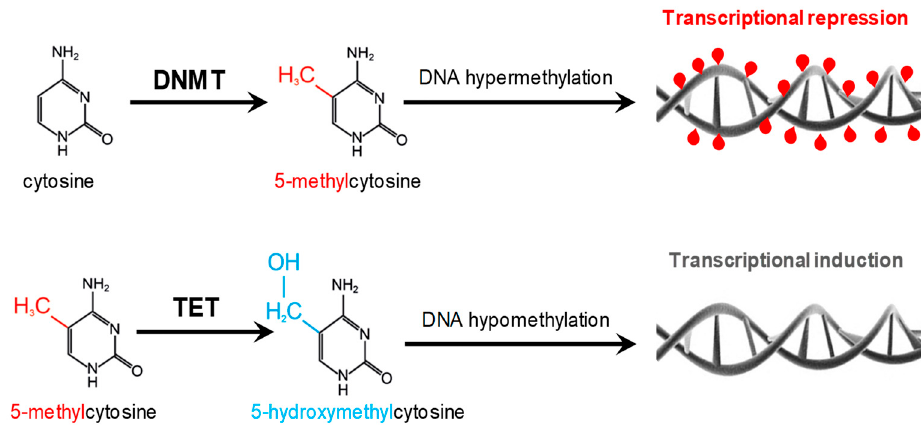
Figure 2. E ff ects of DNA hypermethylation ( upper ) and hypomethylation ( lower ) on transcriptional Figure 2. Effects of DNA hypermethylation (upper) and hypomethylation (lower) on transcriptional activity. DNMT, DNA methyltransferase; TET, Ten-eleven translocation activity. DNMT, DNA methyltransferase; TET, Ten-eleven translocation enzymes.